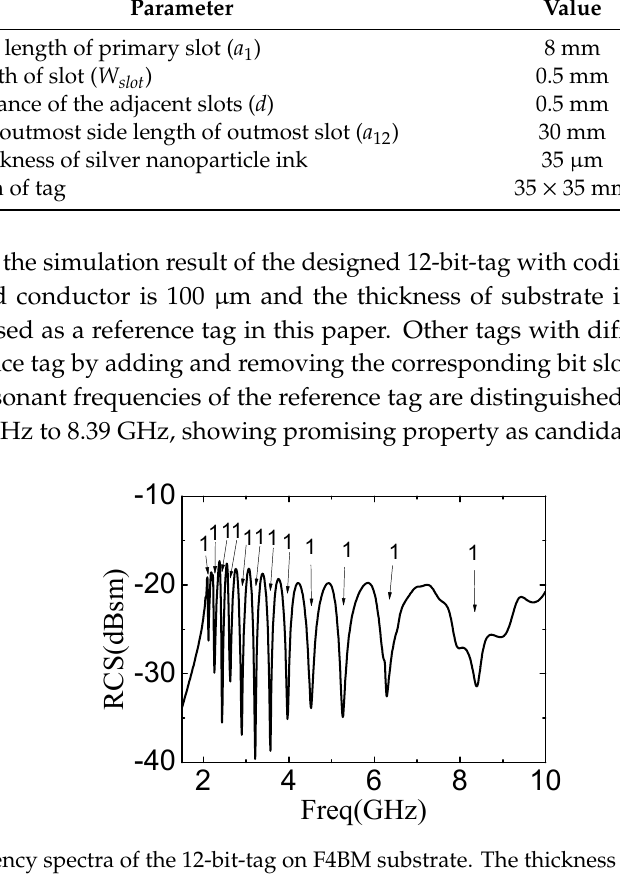
Figure 6. Frequency spectra of the 12 ‐ bit ‐ tag on F4BM substrate. The thickness of substrate is 1 mm.